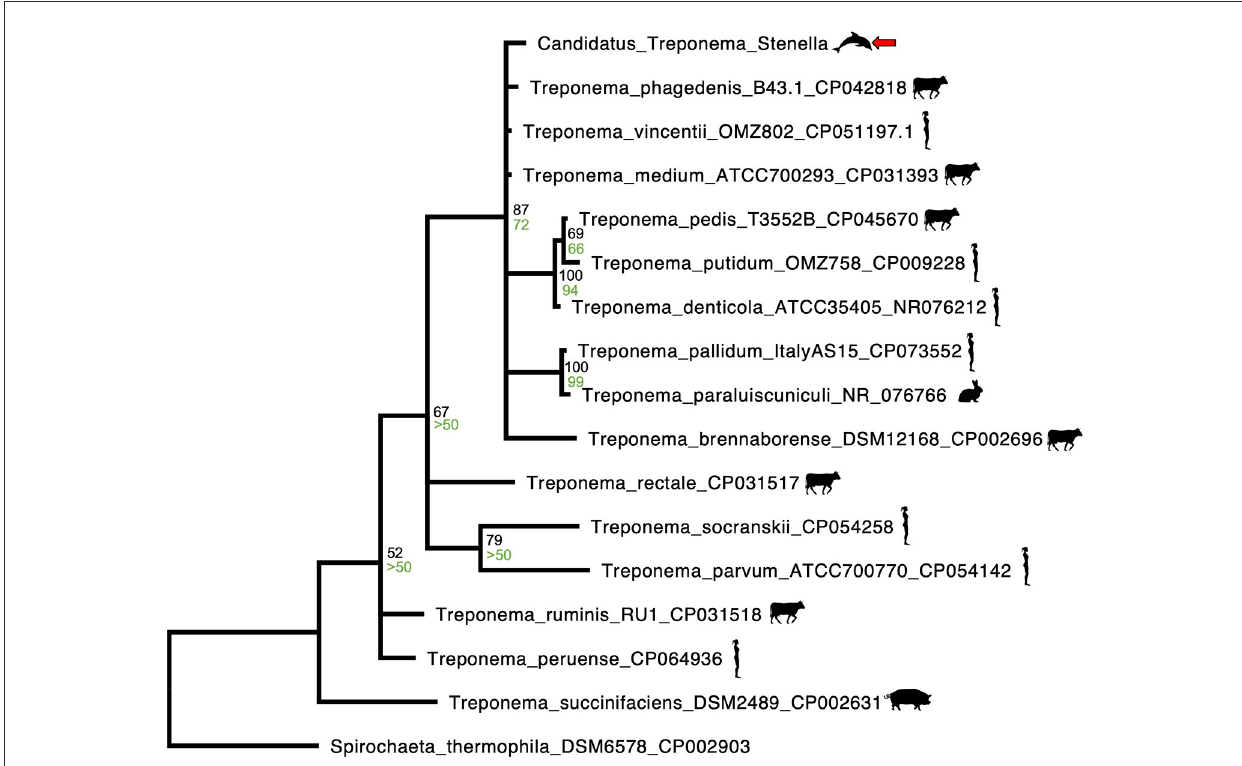
FIGURE4 MAFFT alignment Bayesian phylogenetic tree representative of homologous 170 to 173 base pair 23S rRNA sequences of Spirochaetes closely related to a novel Treponema species identified from an ulcerative tongue lesion in a Stenella frontalis . The outgroup used was Spirochaeta thermophila (Genbank accession CP002903). Bayesian posterior probabilities are written in black, above the maximum likelihood bootstrap values, which are written in green. Both posterior probabilities and maximum likelihood bootstrap values were rounded to the nearest whole percent. The novel Treponema species ( Candidatus Treponema stenella) is identified by a red arrow, Treponema spp. associated with bovids, humans, pigs or rabbits are identified by accompanying graphics of those